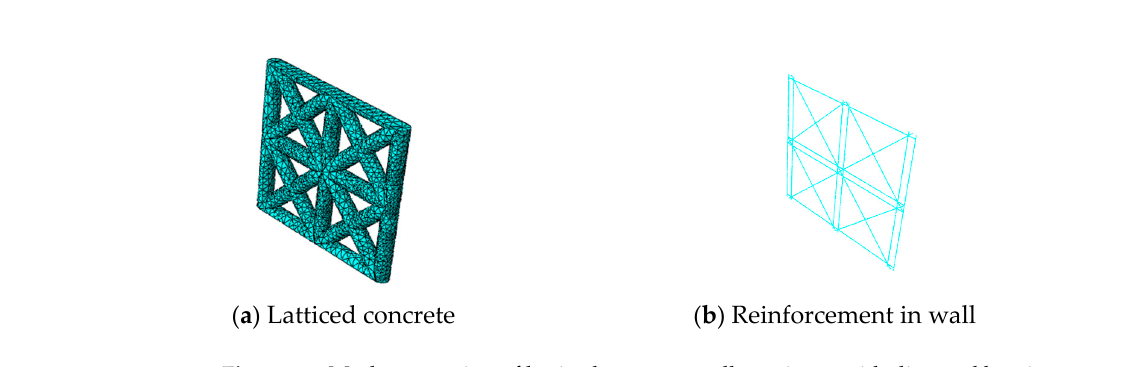
12 of 16 Figure 12. Reinforcement load-strain hysteresis curves at the bottom of the lattice side column. At the later stage of loading, the vertical reinforcement bars at the bottom of the lat- tice side columns of each specimen had all yielded, and the strains were close to or greater than 5000 με . The strain of the steel bars of the traditional specimens was generally larger than that of the new specimens with diagonal bracing, indicating that the addition of di- agonal bracing delayed the development of the lateral displacement of the wall and im- proved the seismic performance of the composite wall. The increase in the core hole di- ameter also slowed down the strain development of the vertical reinforcement at the bot- tom of the lattice side column. 4. Numerical Simulations 4.1. Numerical Model In order to understand the stress condition of the specimen in the whole process of loading, the finite element software ABAQUS 6.14 [38] was applied and a simplified mod- eling method was adopted. Ignoring the contribution of EPSC to the seismic performance of the composite wall, a numerical simulation analysis of a pseudo-static test was carried out on a new latticed concrete wall with diagonal bracing whose core hole diameters were 120 mm and 160 mm. The solid element was used to model concrete, and the T3D2 truss element was embedded into the concrete to model reinforcement. The finite element model and the mesh generation of the new latticed concrete wall with diagonal bracing are shown in Figures 13 and 14.